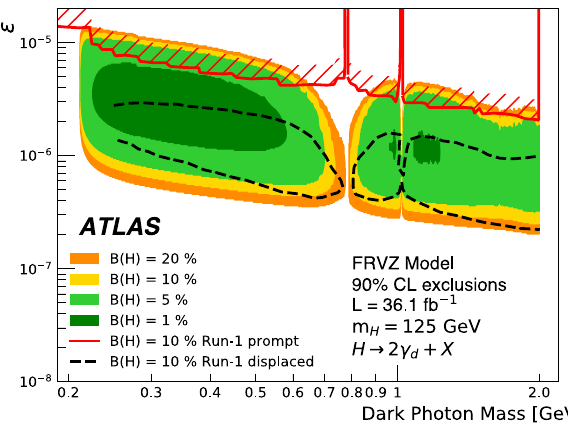
Fig. 7 The 90% CL exclusion regions for the decay H → 2 γ d + X of the Higgs boson as a function of the γ d mass and of the kinetic mix- ing parameter (cid:4) . These limits are obtained assuming the FRVZ model with decay branching fractions of the Higgs boson into γ d between 1 and 20%, and the NNLO Higgs boson production cross sections via gluon–gluon fusion. The figure also shows excluded regions with decay branching fraction of the Higgs boson into γ d of 10% from the run-1 ATLAS displaced [11] (black line) and prompt [14] (red line) dark- photon jets